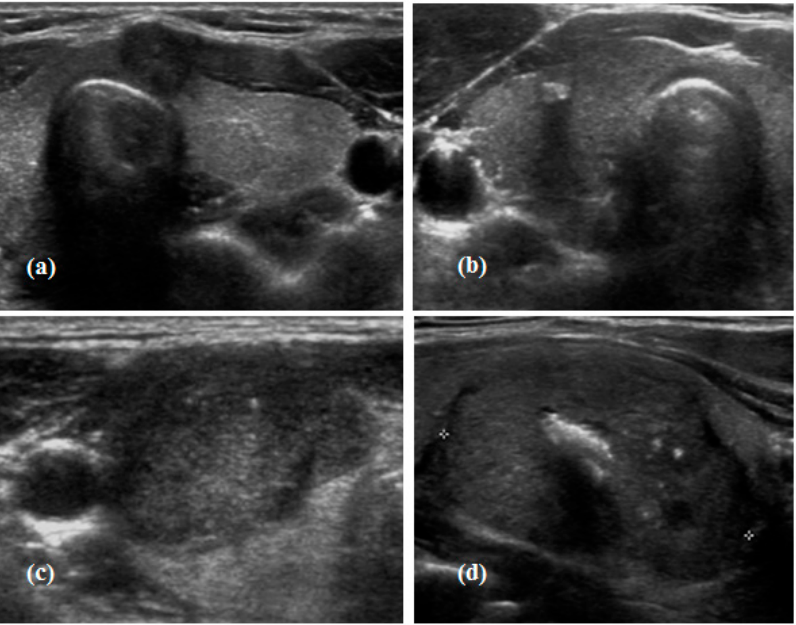
Figure 1. Transverse ultrasound imaging of calcification patterns observed in the study groups according to the extent of calcification. ( a ) No calcification; ( b ) macrocalcification, echogenic foci >1 mm with posterior shadowing; ( c ) microcalcification, punctuated echogenic foci of <1 mm without posterior shadowing, brighter echo than the surrounding thyroid tissue; ( d ) mixed calcification, a combination of macrocalcification and microcalcification.